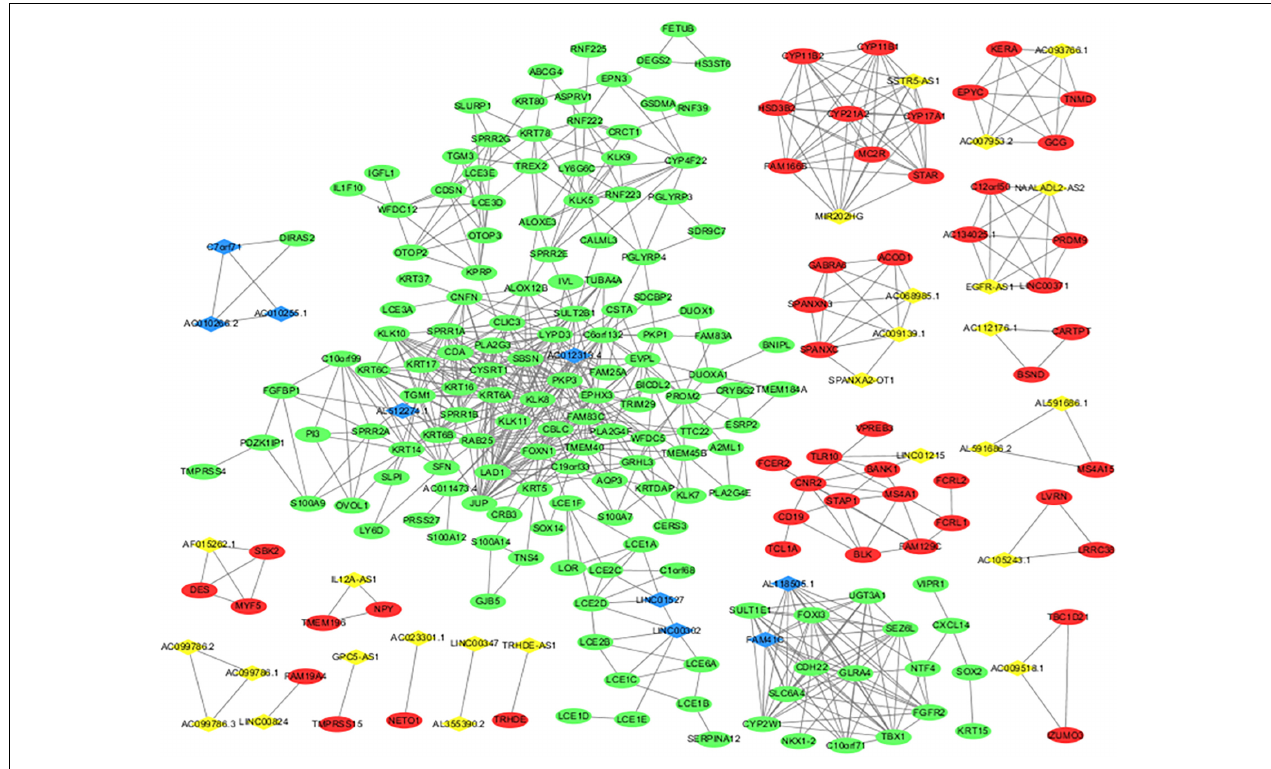
FIGURE 3 | lncRNA and mRNA co-expression network in melanoma. The co-expression network established with 235 nodes and 762 edges, in which only edges with weight(w) above a threshold of 0.8 are displayed. The yellow nodes denote upregulated lncRNAs and the blue nodes denote downregulated lncRNAs. The red nodes denote upregulated mRNAs and the green nodes denote downregulated